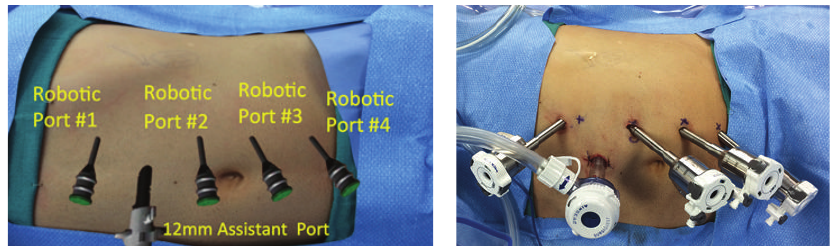
Figure 3: Port placement for left robotic partial nephrectomy.